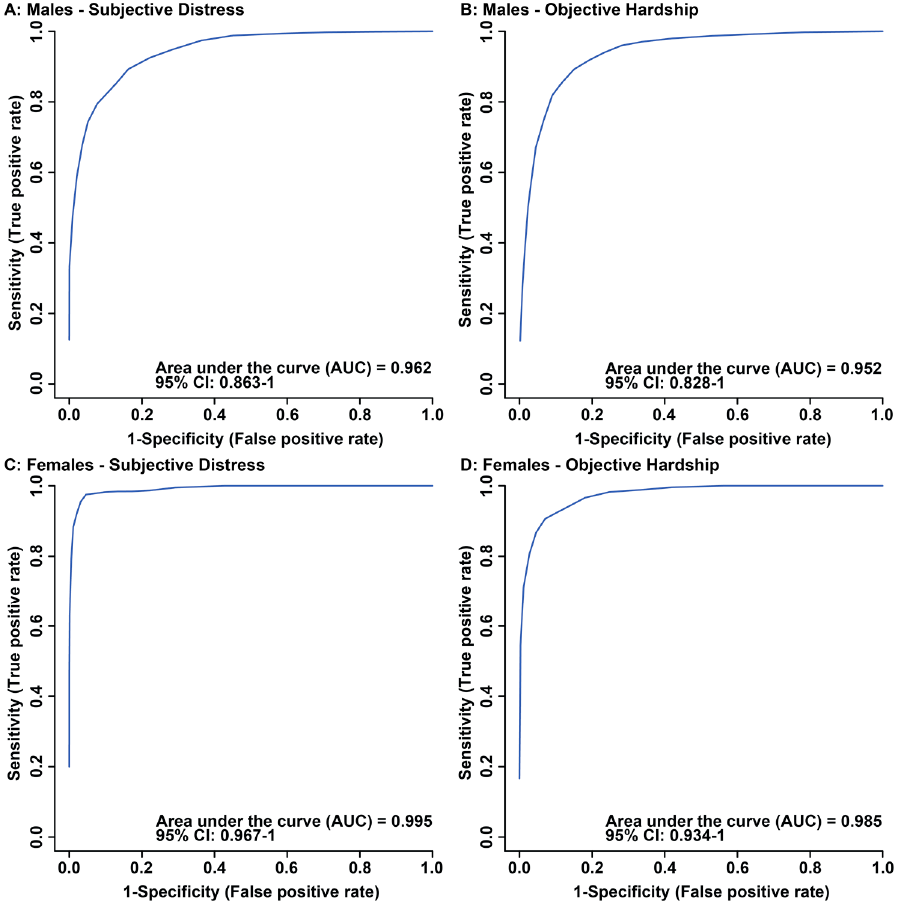
Figure 2. Receiver Operator Characteristic (ROC) curves of maternal composite subjective distress in males ( A ), maternal objective hardship in males ( B ), maternal composite subjective distress in females ( C ), and maternal objective hardship in females ( D ) comparisons. The area under the curve (AUC) and confidence interval (CI) corresponding to the comparison are indicated in each figure. Each fi gure was created utilizing metabolites identi fi ed as signi fi cant by VIAVC best subset.